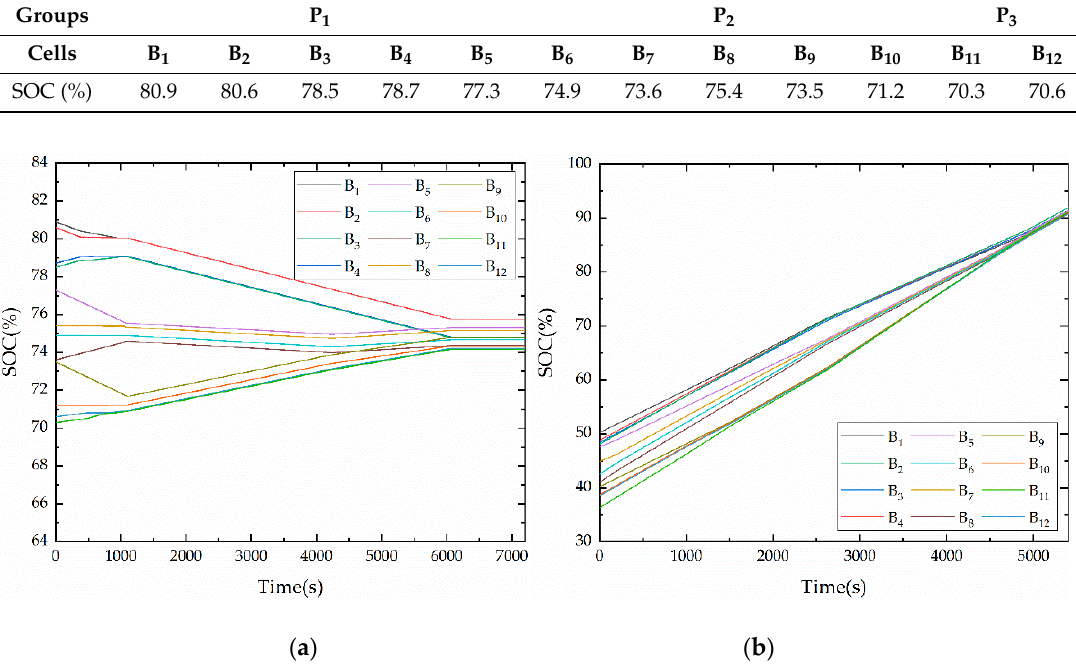
Table 2. The initial SOCs of 12 retired cells for static equalization.